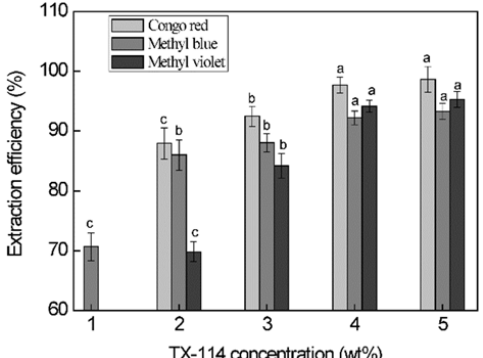
Figure 5. Effect of the Triton X ‐ 114 (TX ‐ 114) concentration on the extraction efficiency of the dyes. (Each system contained 10 mL dyes solution (1 mg/mL CR, MB and 0.125 mg/mL MV), 4 mg Fe 3 O 4 @NH 2 , 40 min vibration time, and incubated at temperature 40 °C for 10 min). Different letters in the same series indicate significant difference at p < 0.05 level.